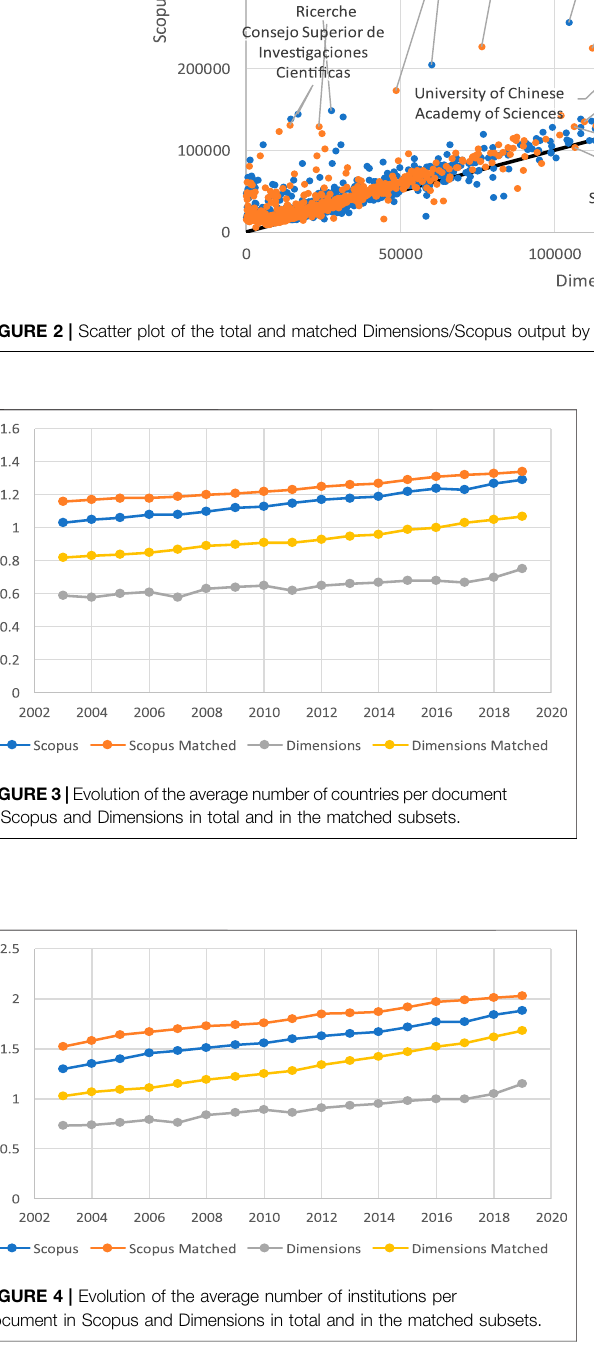
Frontiers in Research Metrics and Analytics |